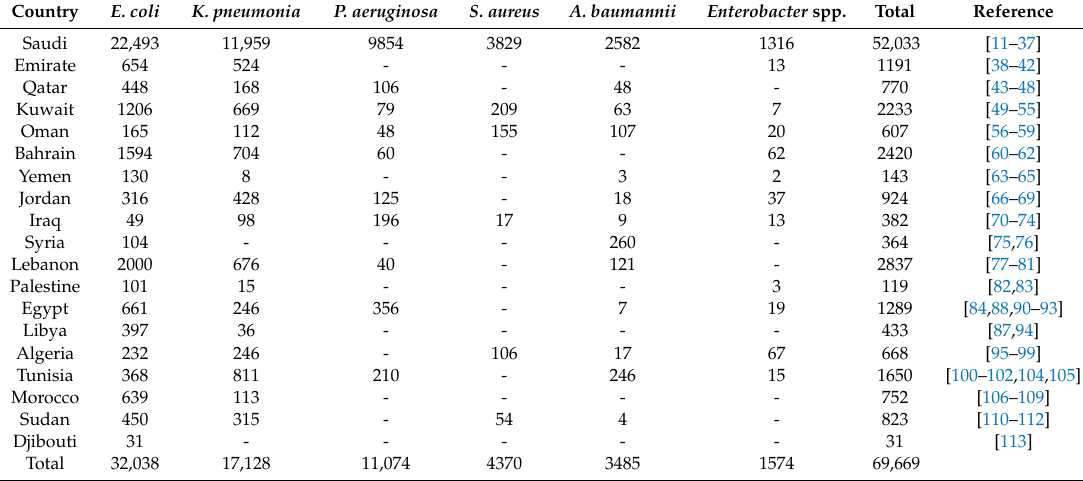
Table 3. Distribution of total E. coli and ESKAPE pathogens in separate Arab region countries during 2000–2020.